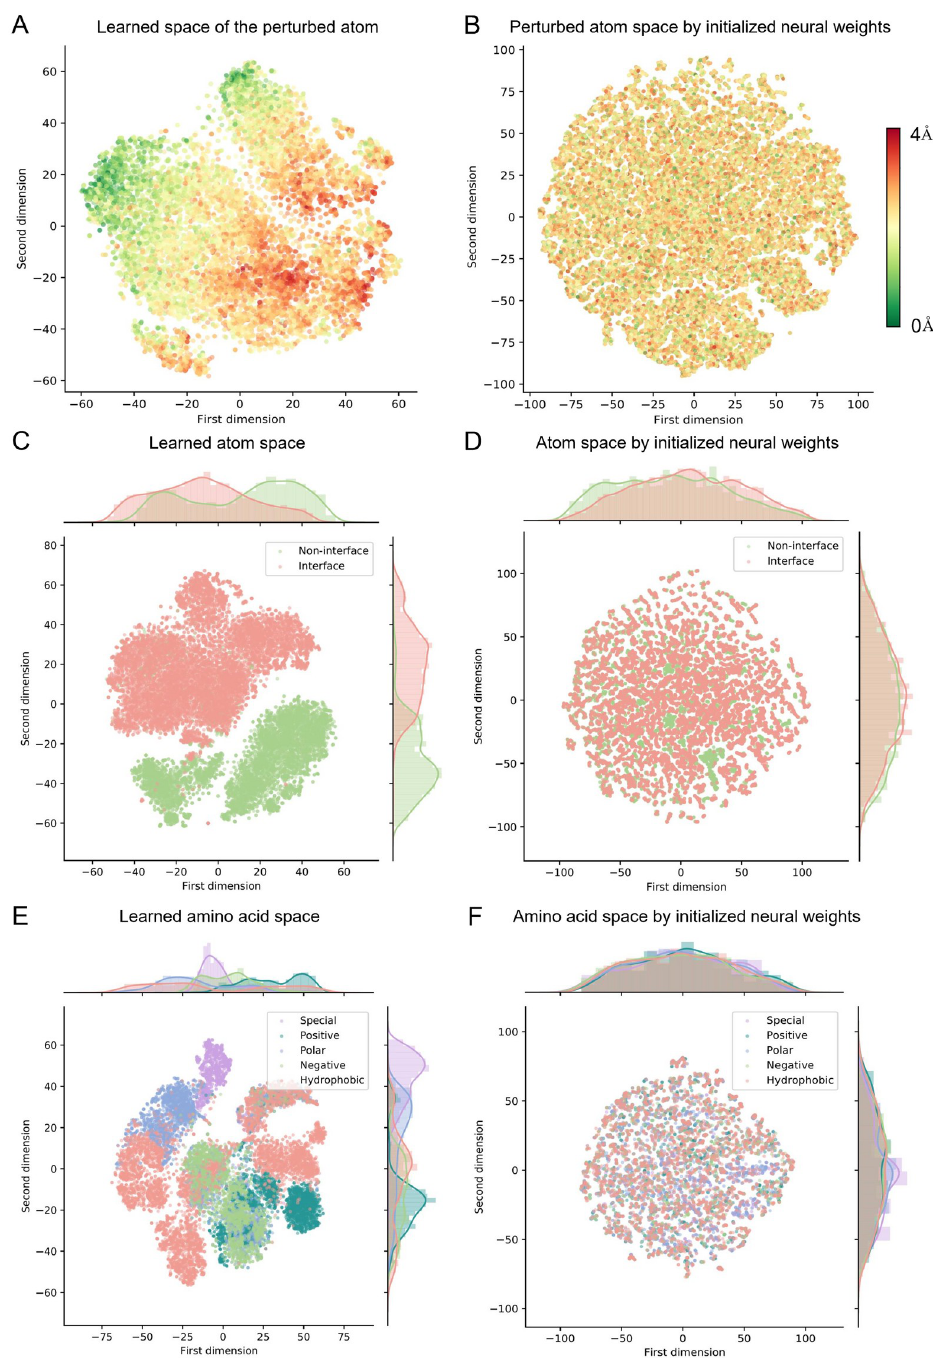
Fig 2. Visualization of the representation space of individual elements in the protein structure. (A) The learned representation space of the atoms with different perturbed distances. (B) The representation space of the perturbed atoms by initialized neural weights (i.e., the weights are not tuned by self-supervised learning). (C) The learned representation space of α -carbon atoms, where the color stands for their locations (on or not on the interface) in complexes. (D) The space of α -carbon atoms by initialized neural weights. (E) The learned amino acid space, where the color indicates the corresponding group. (F) The amino acid space by initialized neural weights.